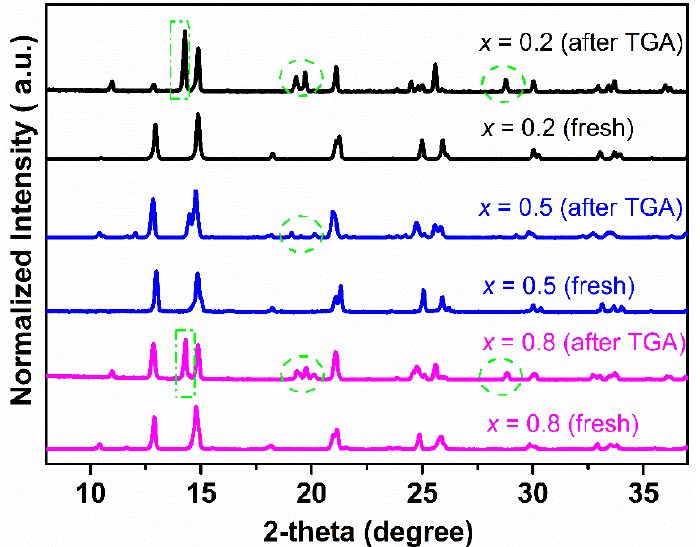
Figure 5. XRD patterns of Ce 0.9 Pr 0.1 O 2 − δ –Nd x Sr 1– x Fe 0.9 Cu 0.1 O 3 − δ ( x = 0.2, 0.5, 0.8) bulk samples before and after TGA measurements under a 5 vol% H 2 -95 vol% Ar atmosphere.